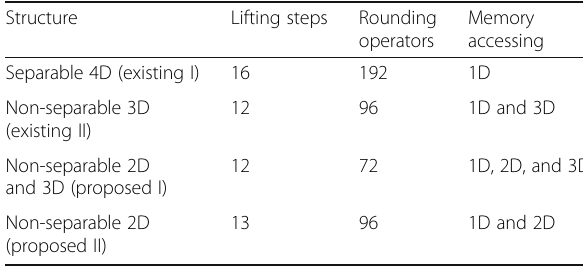
Memory operators